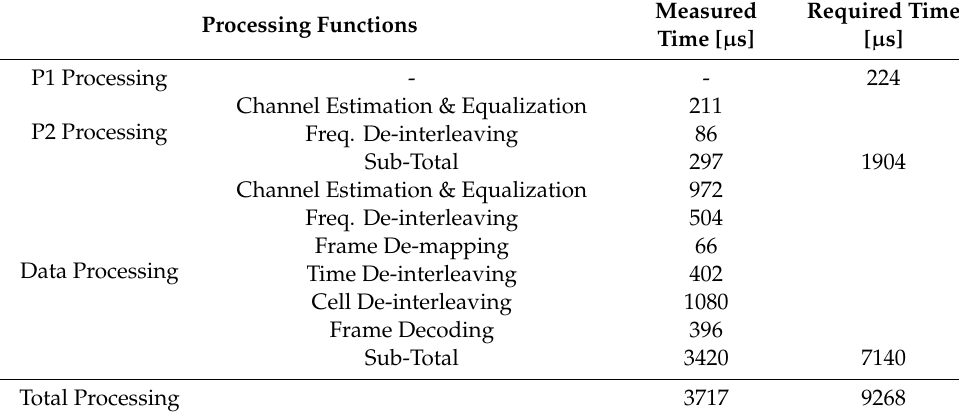
Table 6. Processing time of the frame processor